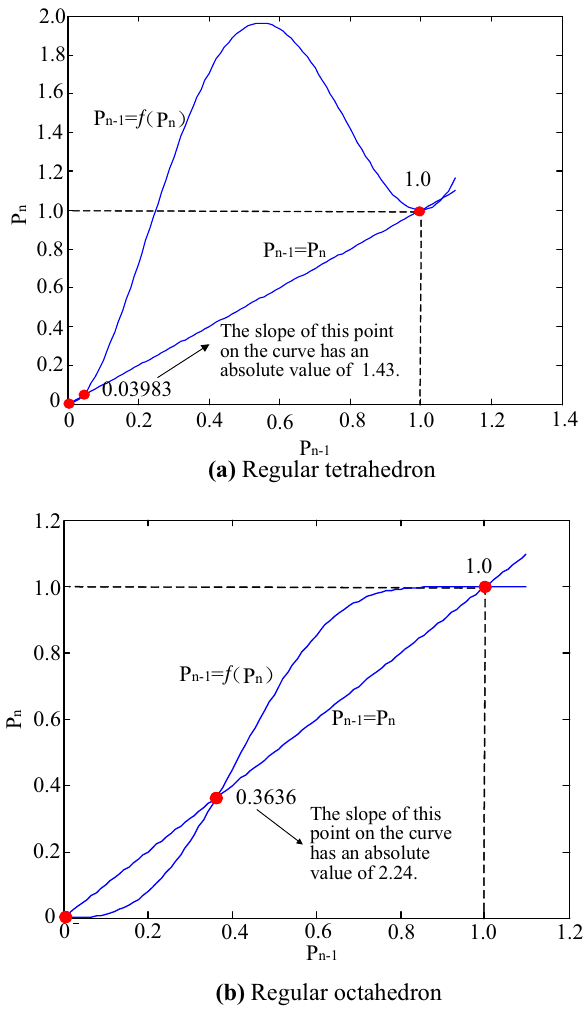
Fig. 11 Solution of the fixed points of the pore-centered regular hexahedron and regular octahedron Table 4 Calculated solutions to the fixed points in the pore-centered microstructural units of weakly cemented sandstone Structural